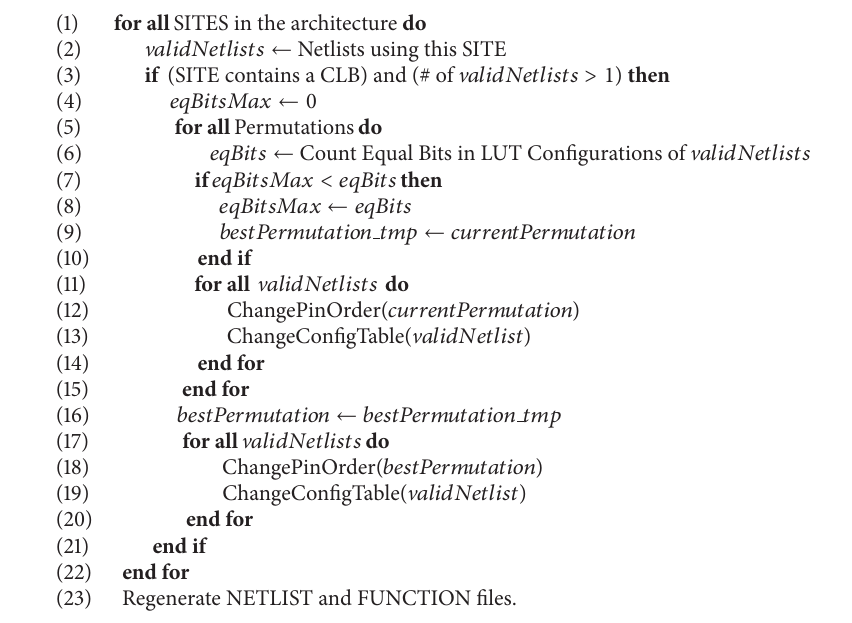
Algorithm 1: Algorithm for the LUT optimization.